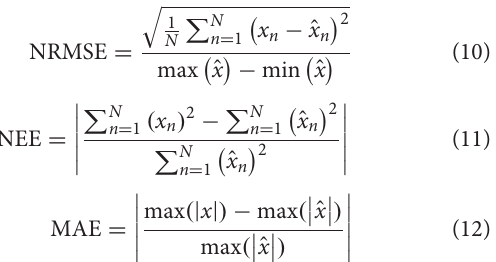
a single output value per time step. For this study, the 2D data format was considered for the output shape of the